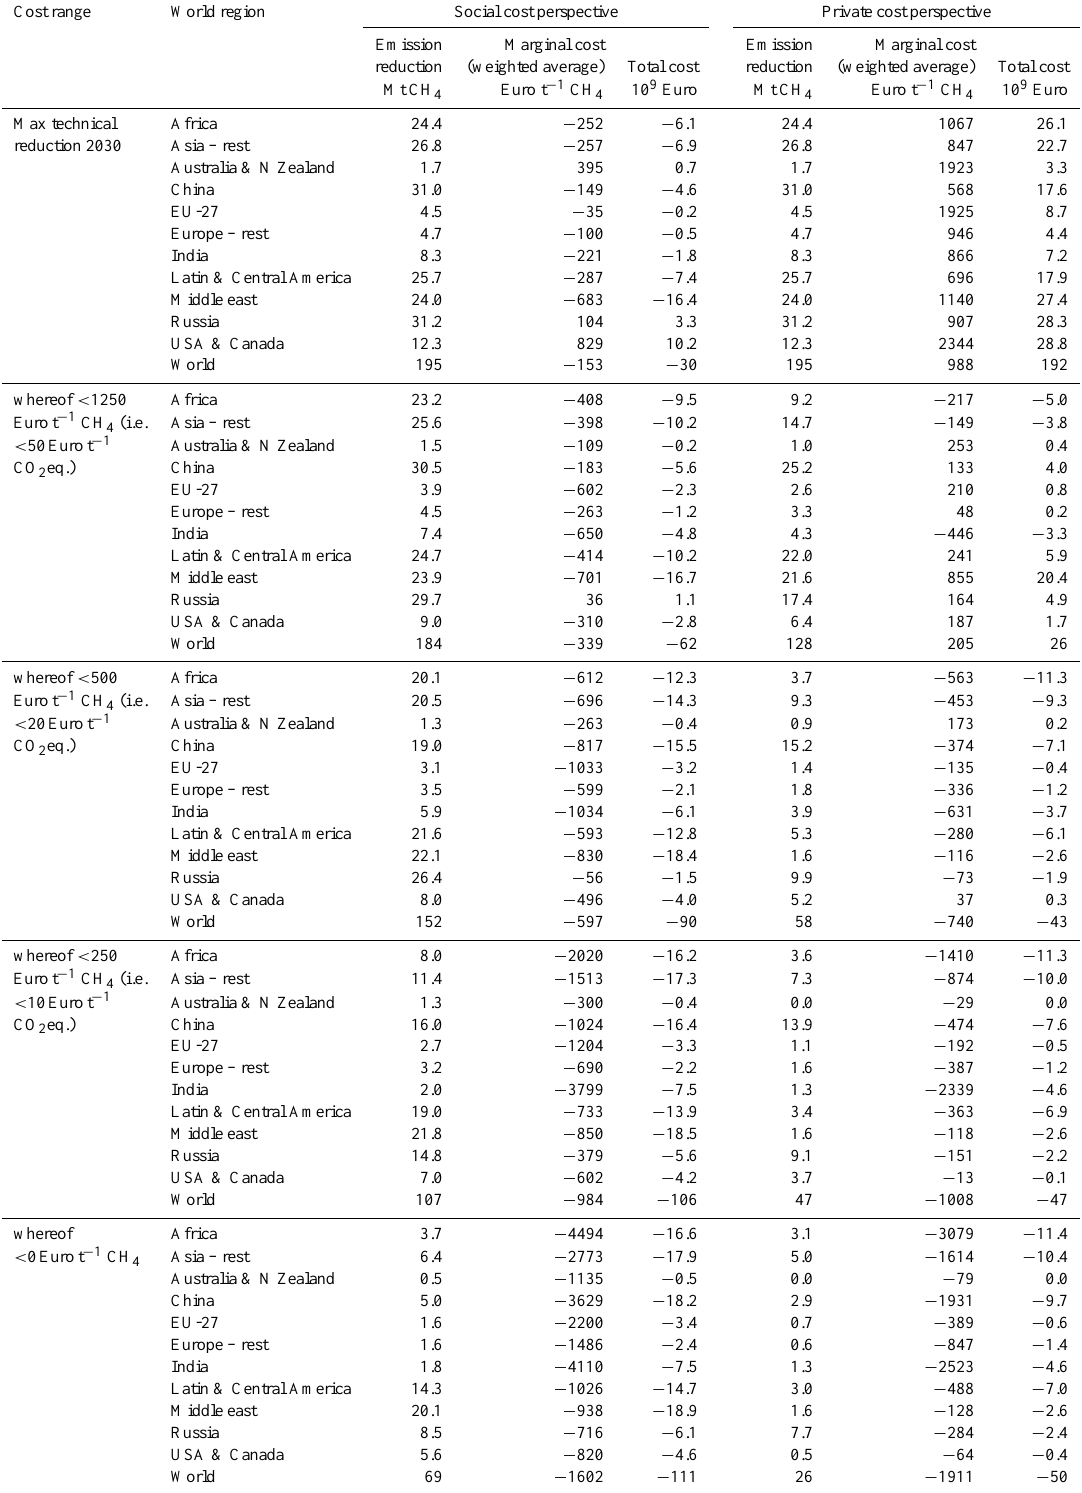
Table 8. Costs for CH 4 technical mitigation potentials in 2030 by world region. Cost